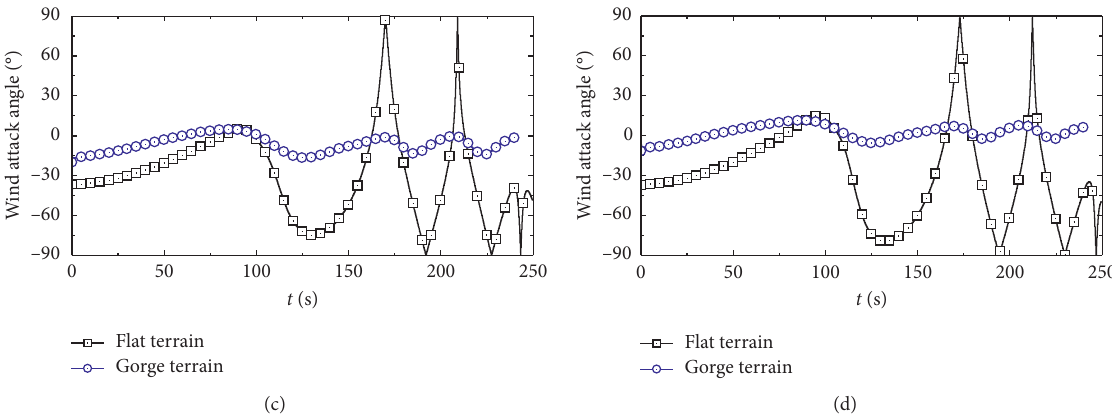
Figure 13: Comparisons between the time-history curves of wind attack angle in the flat and gorge terrains. (a) z � 0m. (b) z � 150m. (c) z � 300m. (d) z �